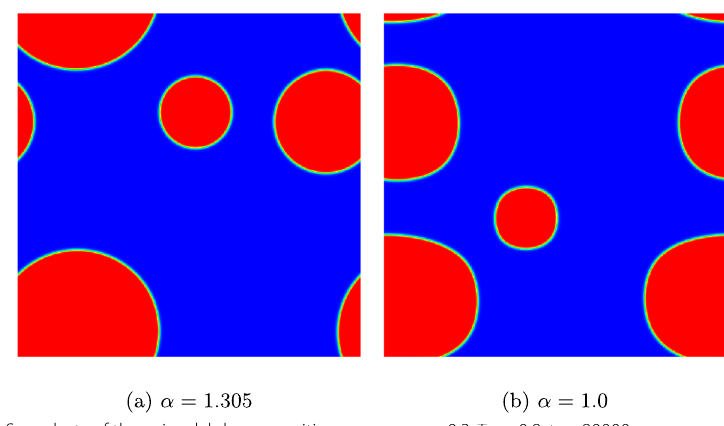
Fig. 17 Snapshots of the spinodal decomposition process, τ = 0.3 , T r = 0.8 , t =